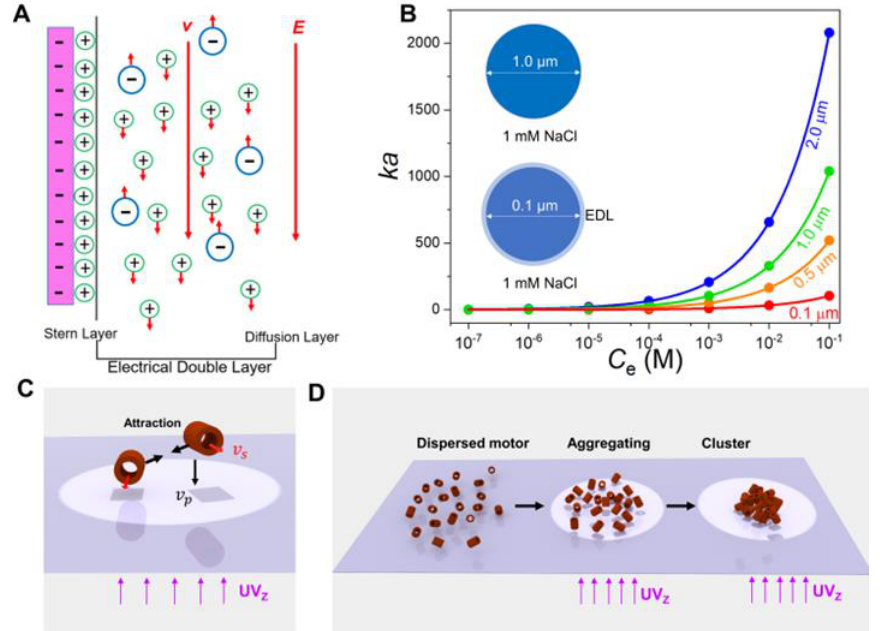
Figure 1. Conceptual design of ion-tolerable ultrasmall Fe 2 O 3 TNMs. ( A ) Schematic diagram of the electrical double layer on a micro/nanomotor based on self-electrophoresis or electrolyte diffusiophoresis. ( B ) the ratio of the radius ( a ) to the EDL thickness ( 1/κ ) of a micro/nanomotor ( κa ) as a function of ion concentrations ( C e ). ( C ) Light-driven propulsions and local interactions of two adjacent nanomotors under vertical upward UV irradiation (UV Z ). ( D ) Schematic diagram of swarming behaviors of the Fe 2 O 3 TNMs under UV Z irradiation.